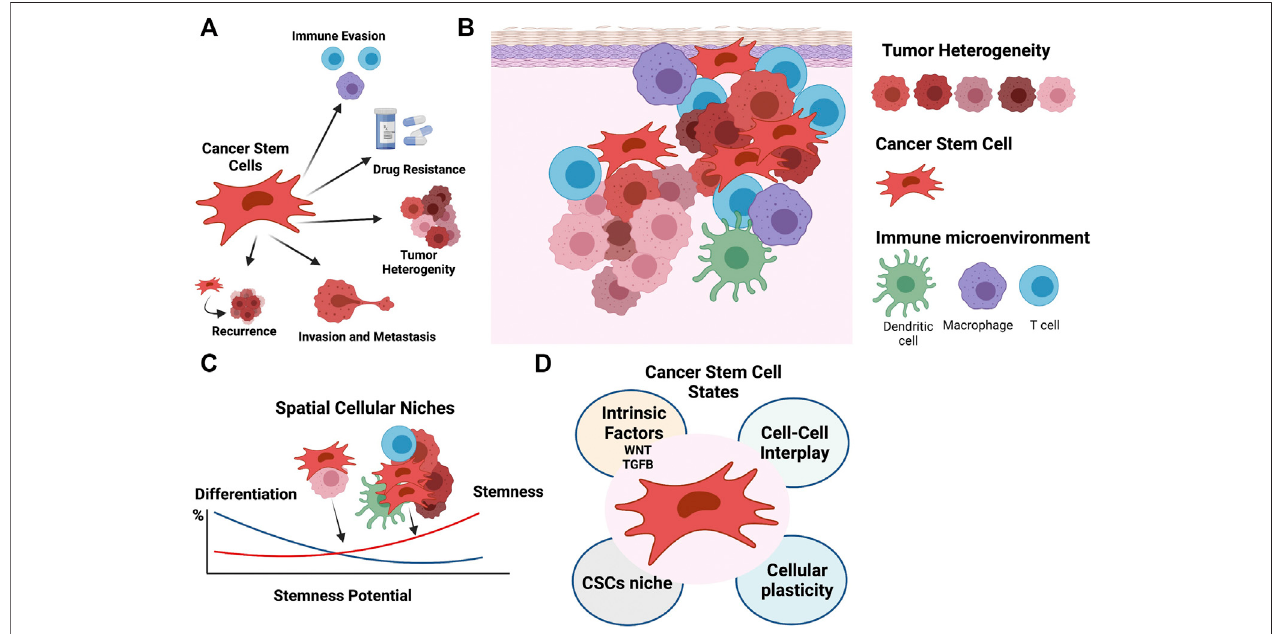
FIGURE1 | Thecellular niche sustains the phenotypically diversity ofcancer stem cells. (A) CSCs play fundamental roles in cancer, including contributingto tumor heterogeneity, and immune evasion, promoting migration and recurrence, and driving chemoresistance. (B) The CSC niche is supported by the tumor components, stroma, immune in fi ltrate, and tumor microenvironment. (C) Cell-cell interactions de fi ne spatial cancer niches and contribute to the phenotypically diversity of CSCs and cellular heterogeneity. (D) CSC phenotypic states are modulated by an array of factors, including intrinsic factors like WNT and TGFB pathway activation, cell-cell interactions, cellular plasticity, and the cellular niche. Figure created with